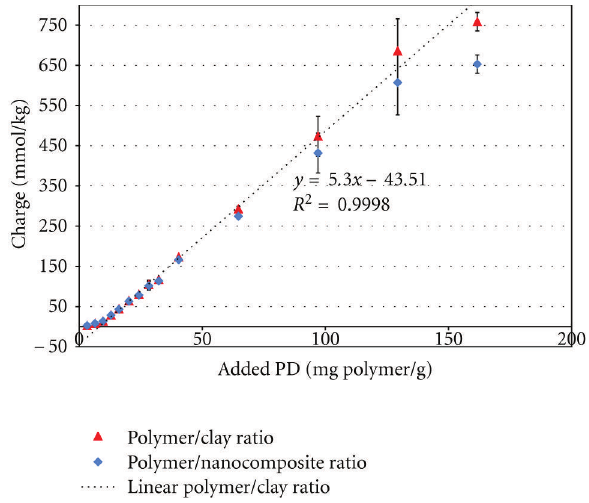
Figure 2: Charge of the nanocomposites as a function of poly- mer/clay ratio (triangle) and polymer/nanocomposite ratio (rhom- bus).